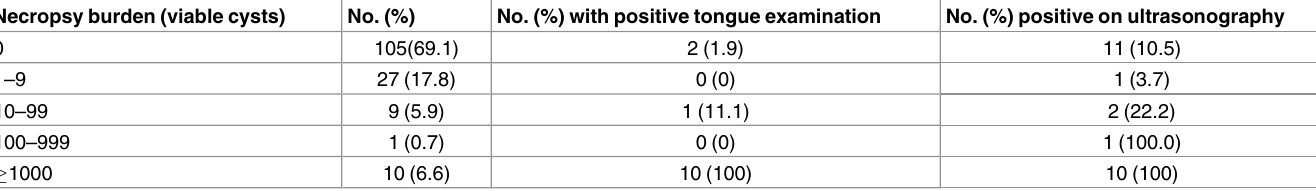
Table 1. Number of viable cysts identified on necropsy compared to tongue and ultrasound examination.